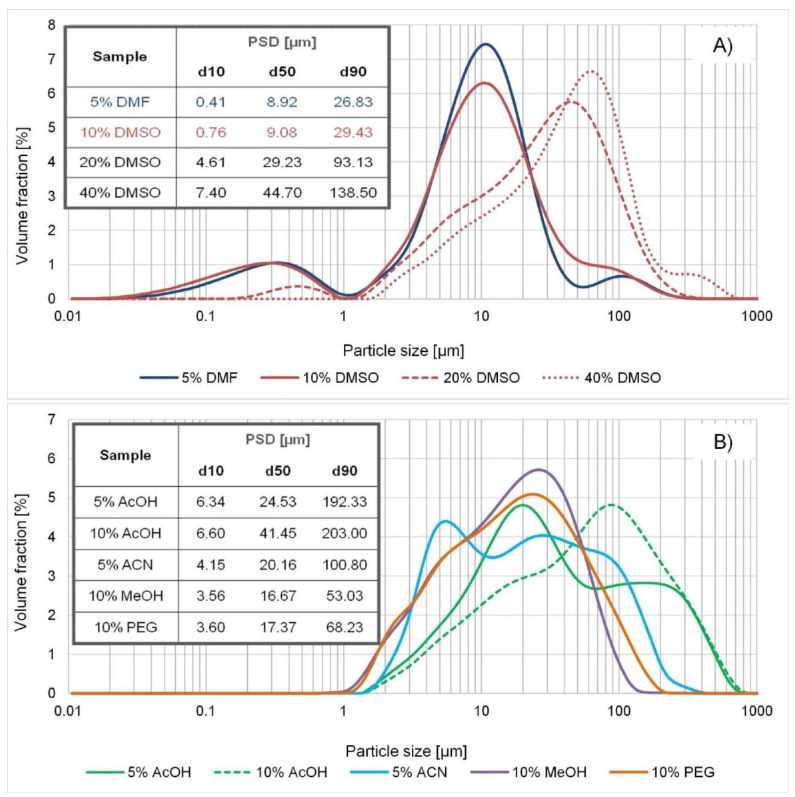
Figure A2. ( A , B ) Particle size distributions of cilostazol precipitated from different solvents without stabilizers at screening stage.